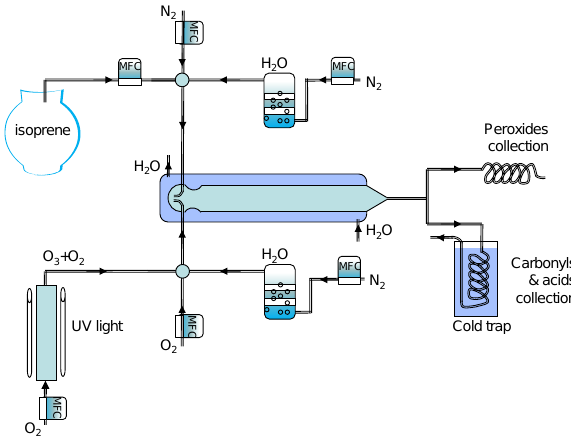
Fig. 1. Schematic diagram of the flow tube reactor and the gas path system. MFC: mass flow